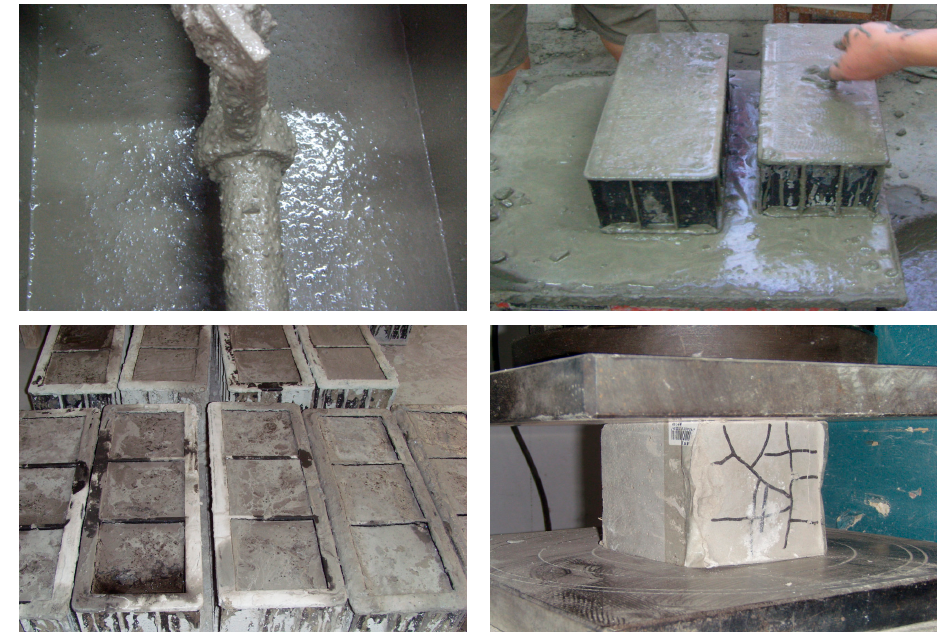
Figure 5. Photos of the experimental process. Table 3. Material contents and test results.